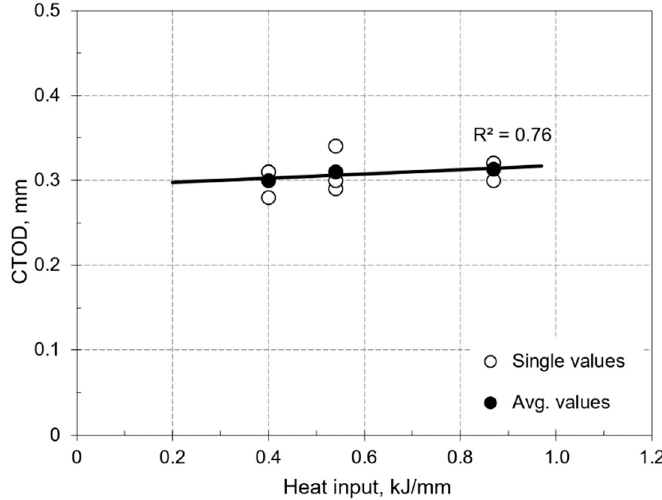
Figure 8. Charpy V-notch toughness of walls and base metal.